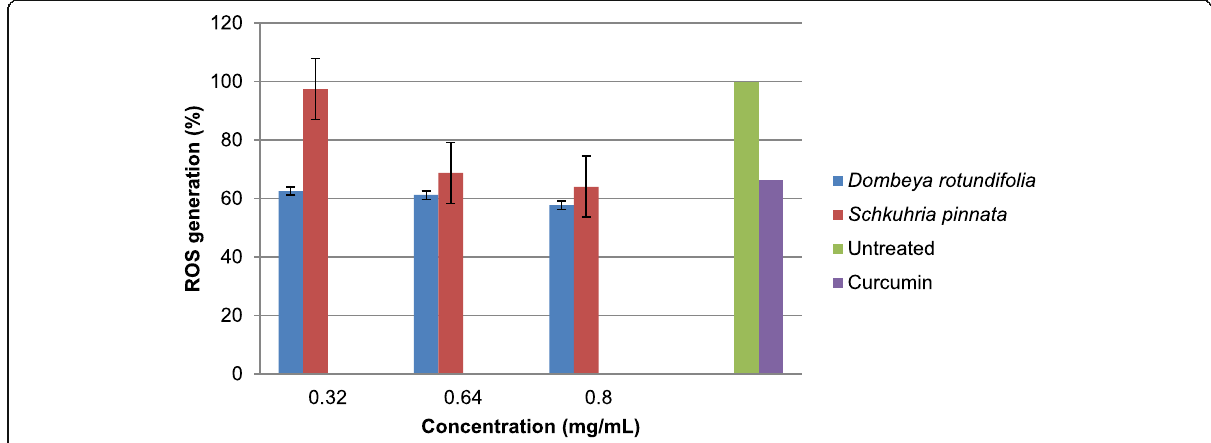
Fig. 1 The effect of two of the selected plants on ROS generation inhibition activity in LPS induced RAW 264.7 macrophage cells